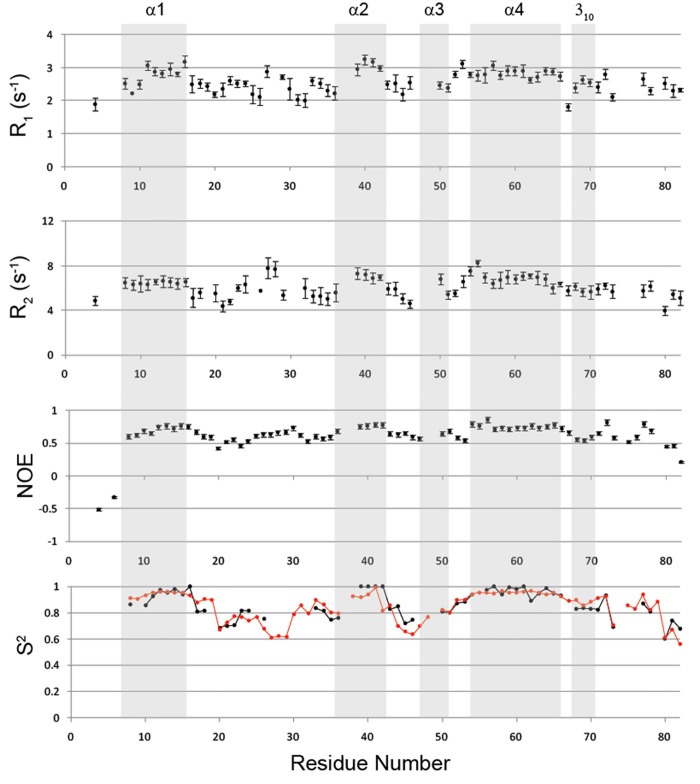
NMR protein dynamics characterization.Relaxation parameters (R
1, R
2, and 15N-{1H}-NOE) and the order parameter S2 (black circle) of RpfCc plotted versus the residue numbers. The order parameter S2 derived from the MD data is also reported (red circle).